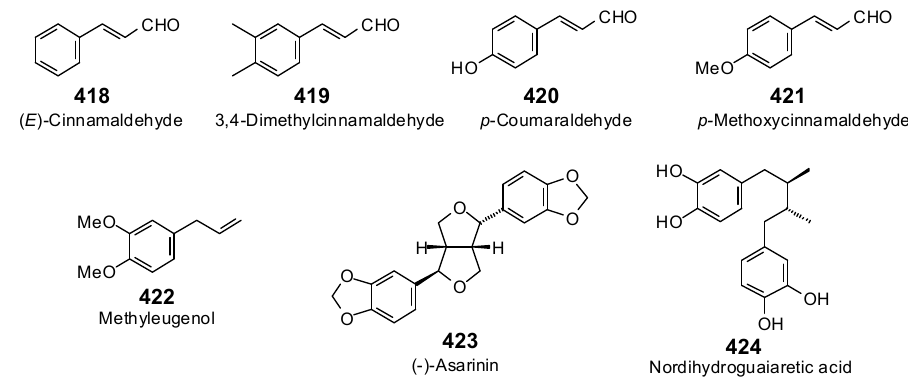
Figure 17. Stilbenoids examined in this work.